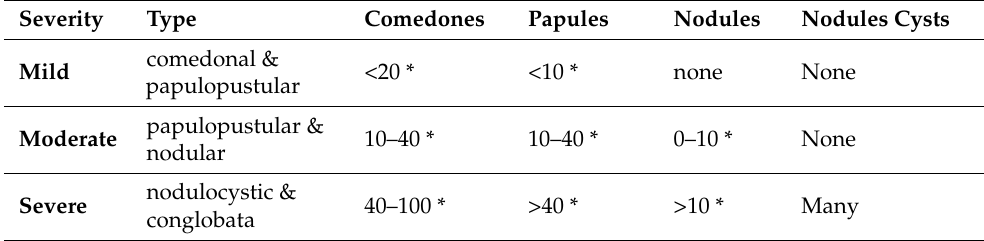
Figure 2. 30-year-old patient with acne tarda suffering from primary ovarian insufficiency (POI). Seborrhea and multiple skin coloured and erythematous follicular papules on the face ( a,b ) and the trunk ( c,d ) [37]. Table 1. Clinical forms of acne [10].